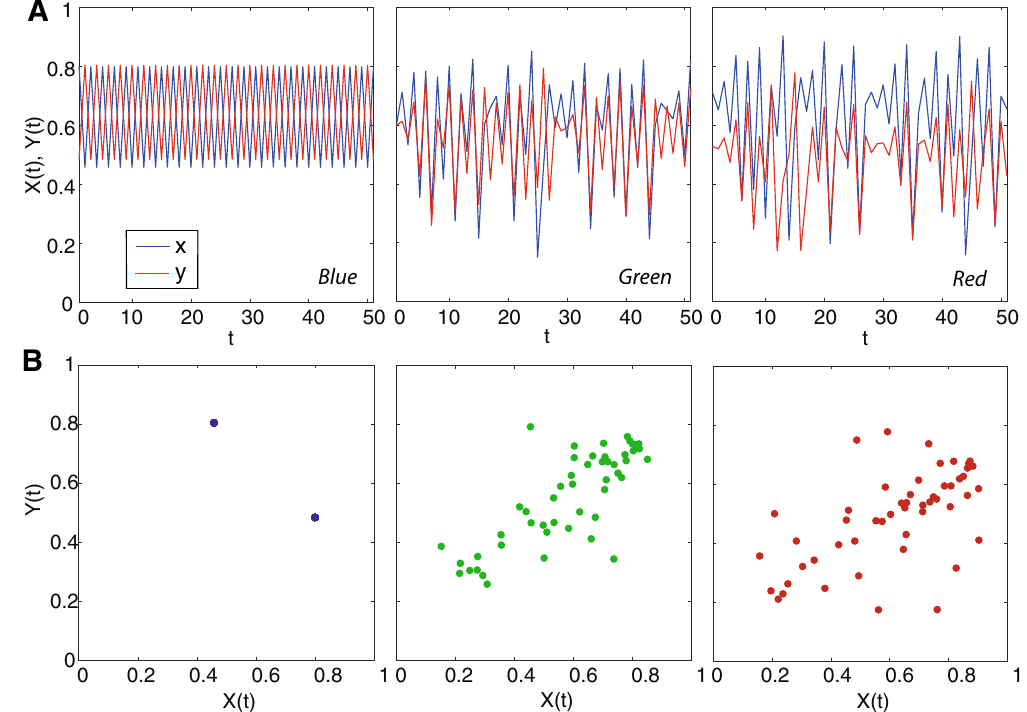
Figure 4. Dynamics of abundance and predictability for the bidirectional two species ecosystem model. ( A ) plots refer to the species abundance in time for the mathematical model in Eq. 1 for different predictability regimes associated to different interaction dynamics from low to high complexity ecosystem associated to low and high predictability. Blue, green and red refer to a range of predictable interactions as in Fig. 3: specifically, Blue is for ( β y x , β x y )=(0.18, 0.39) (small mutual interaction, and predominant effect of Y on X), Green is for (0.64, 0.57) (high mutual interactions, and slightly predominant effect of X on Y), and Red for (0.94, 0.34) (high mutual interactions, and predominant effect of X on Y). ( B ) phase-space plots showing the non-time delayed associations between X and Y corresponding to synchronous and homogeneous, mildly asynchronous and divergent, and asynchronous and divergent dynamics. The transition from synchronous/small interactions to asynchronous/high interaction leads to a transition from modular to nested ecosystem interactions when more than one species exist (Fig.